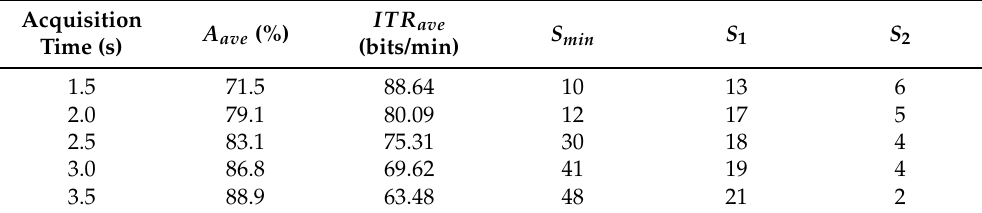
Table 2. Comparison of different data lengths.